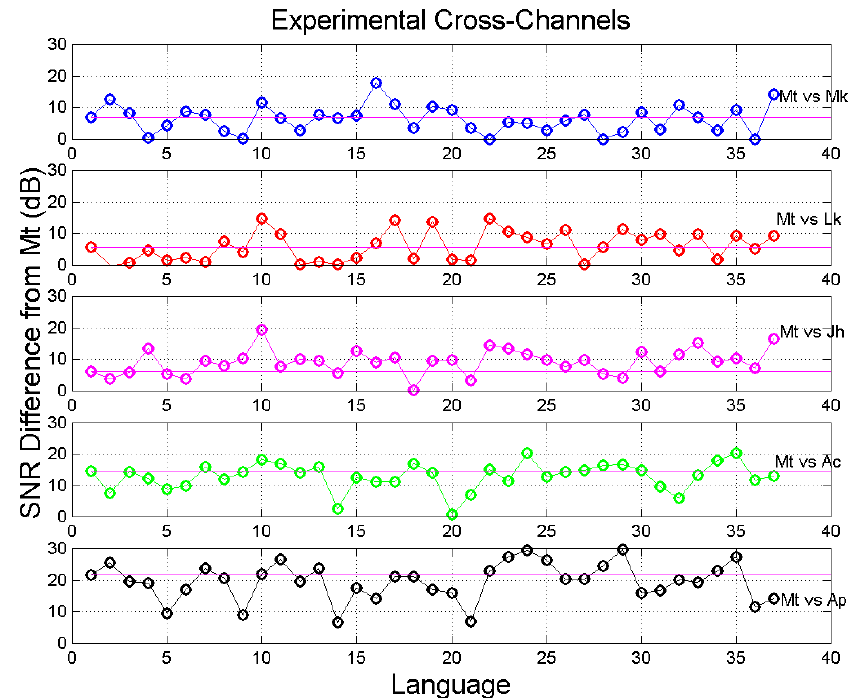
Figure 9. Difference between Γ dB , ex in the self-channel (Mt vs. Mt) and that in the cross-channels, for all languages, according to Figure 8. Languages are ordered according to Table 1. The magenta lines correspond to Greek (1). Color key : blue = Mt vs. Mk; red = Mt vs. Lk; magenta = Mt vs. Jh; green = Mt vs. Ac; black = Mt vs. Ap.